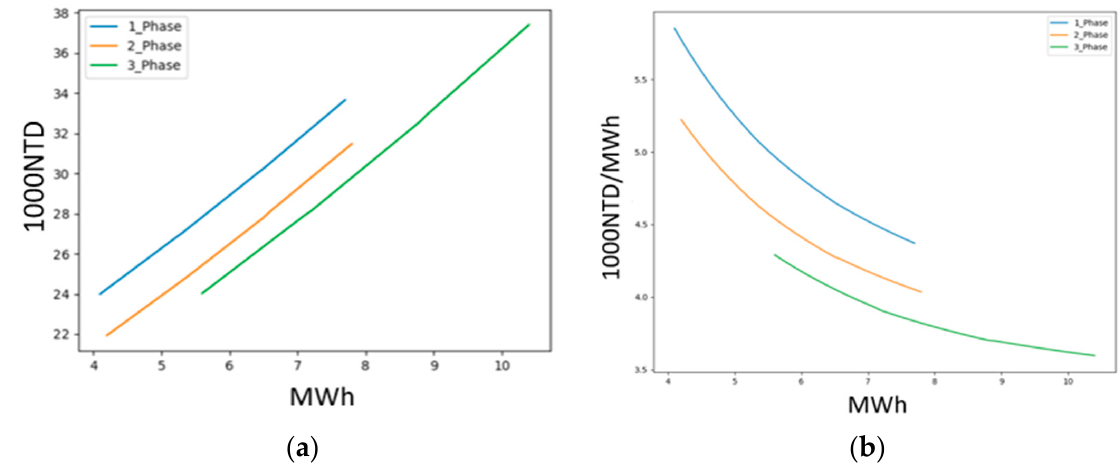
Figure 2. The ( a ) cost curve of the generators, and ( b ) average cost curve.